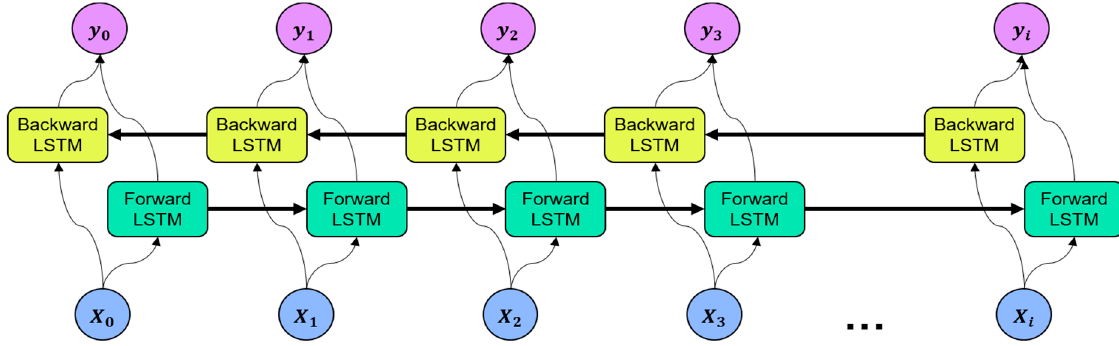
Figure 6. Architecture of bidirectional long short-term memory.